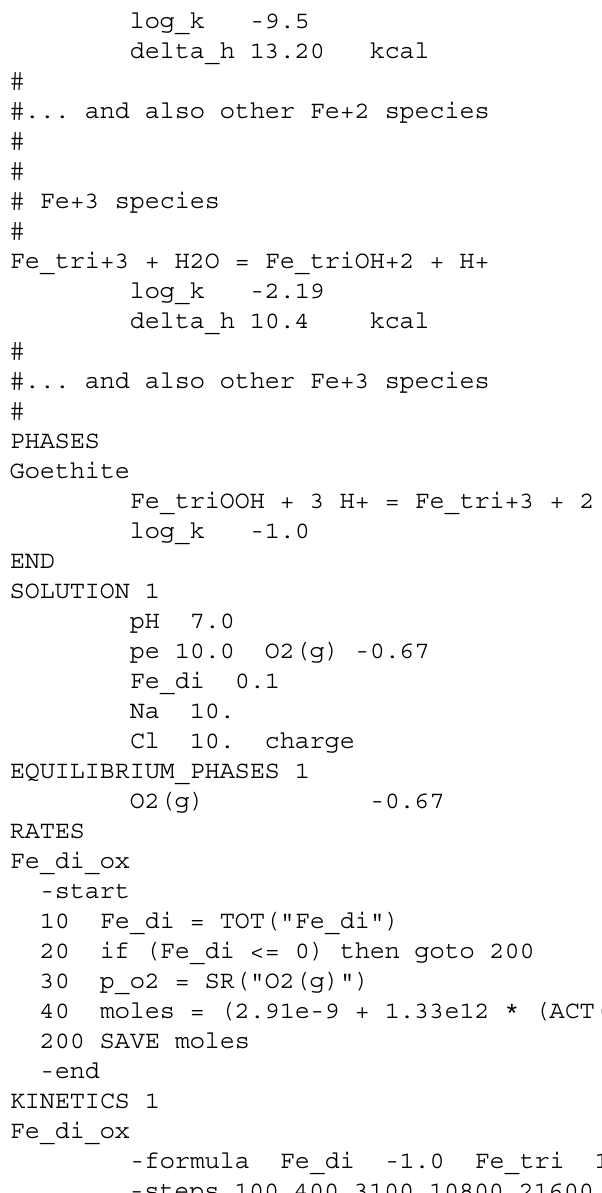
Table 28. Partial input file for example